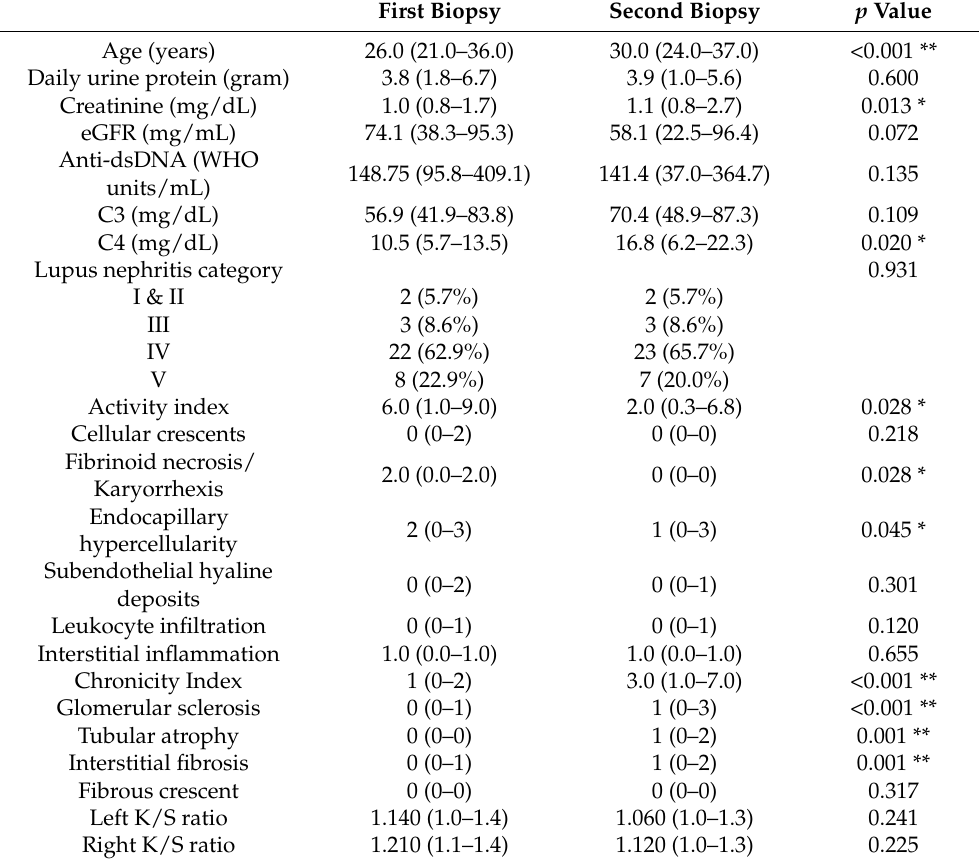
Table 3. Comparisons of clinical, pathological parameters and gallium uptake between two renal biopsies in 35 SLE